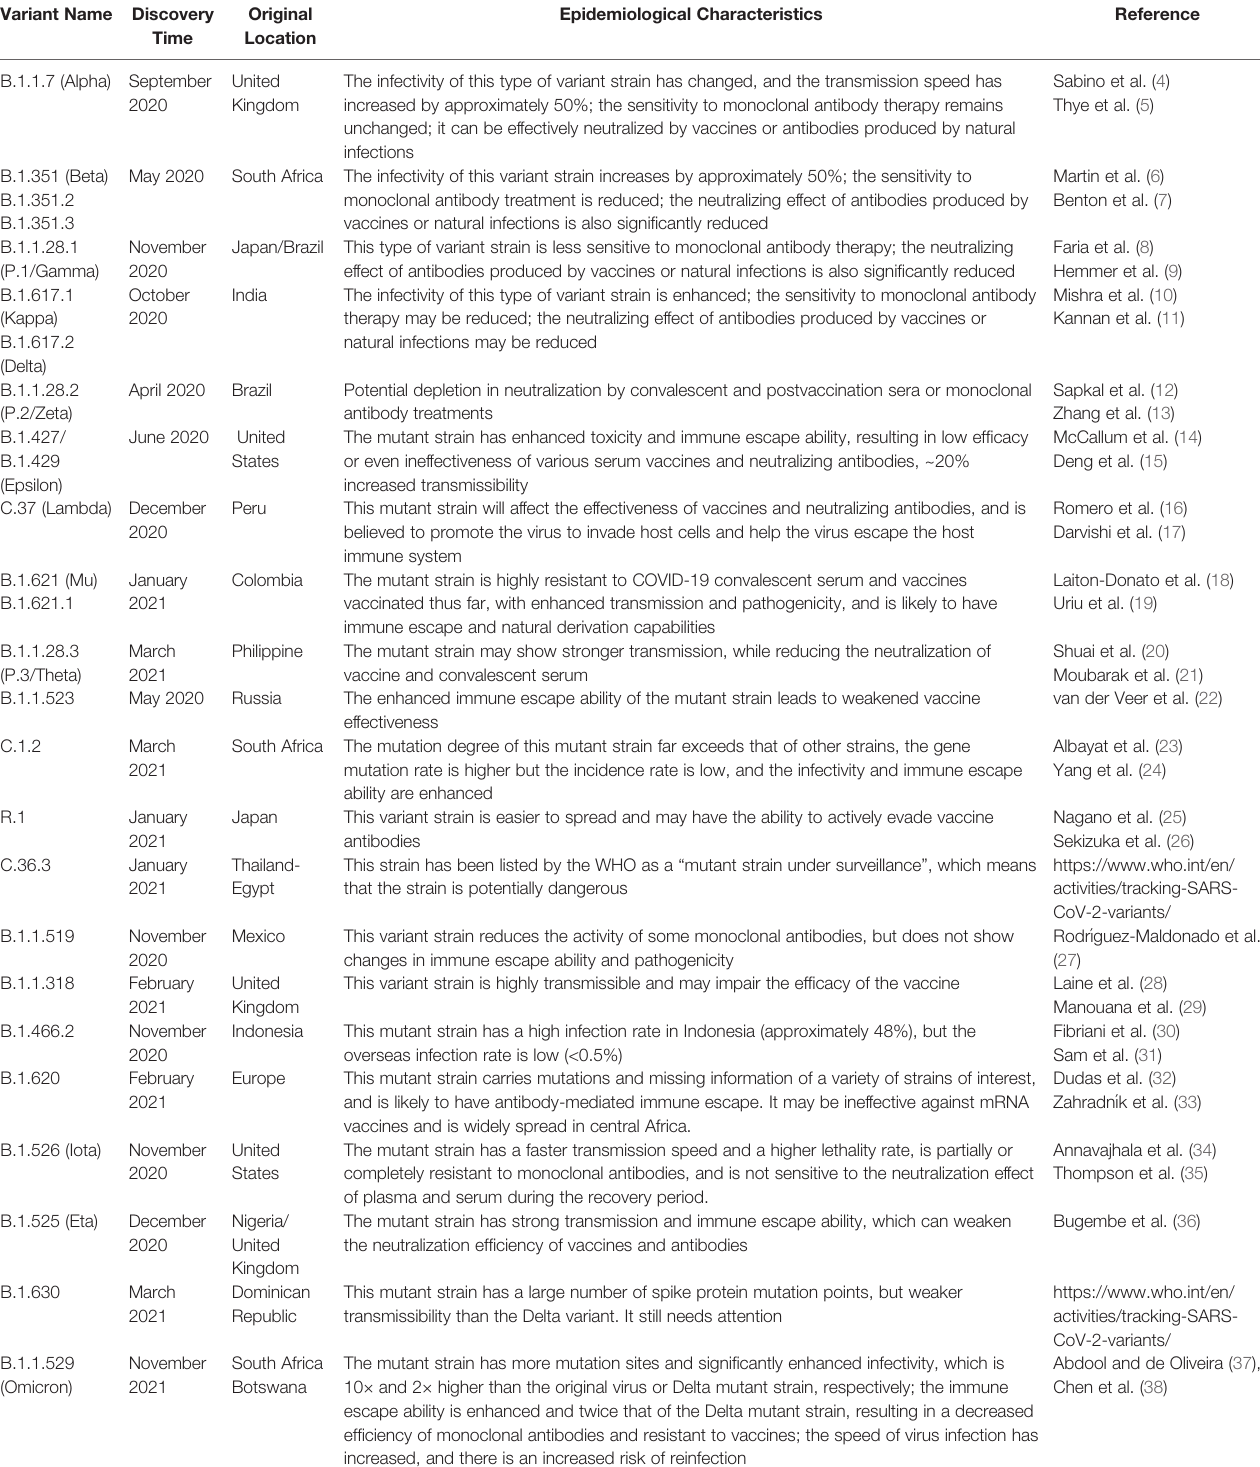
TABLE 1 | Characteristics of the current concerned SARS-CoV-2 variant